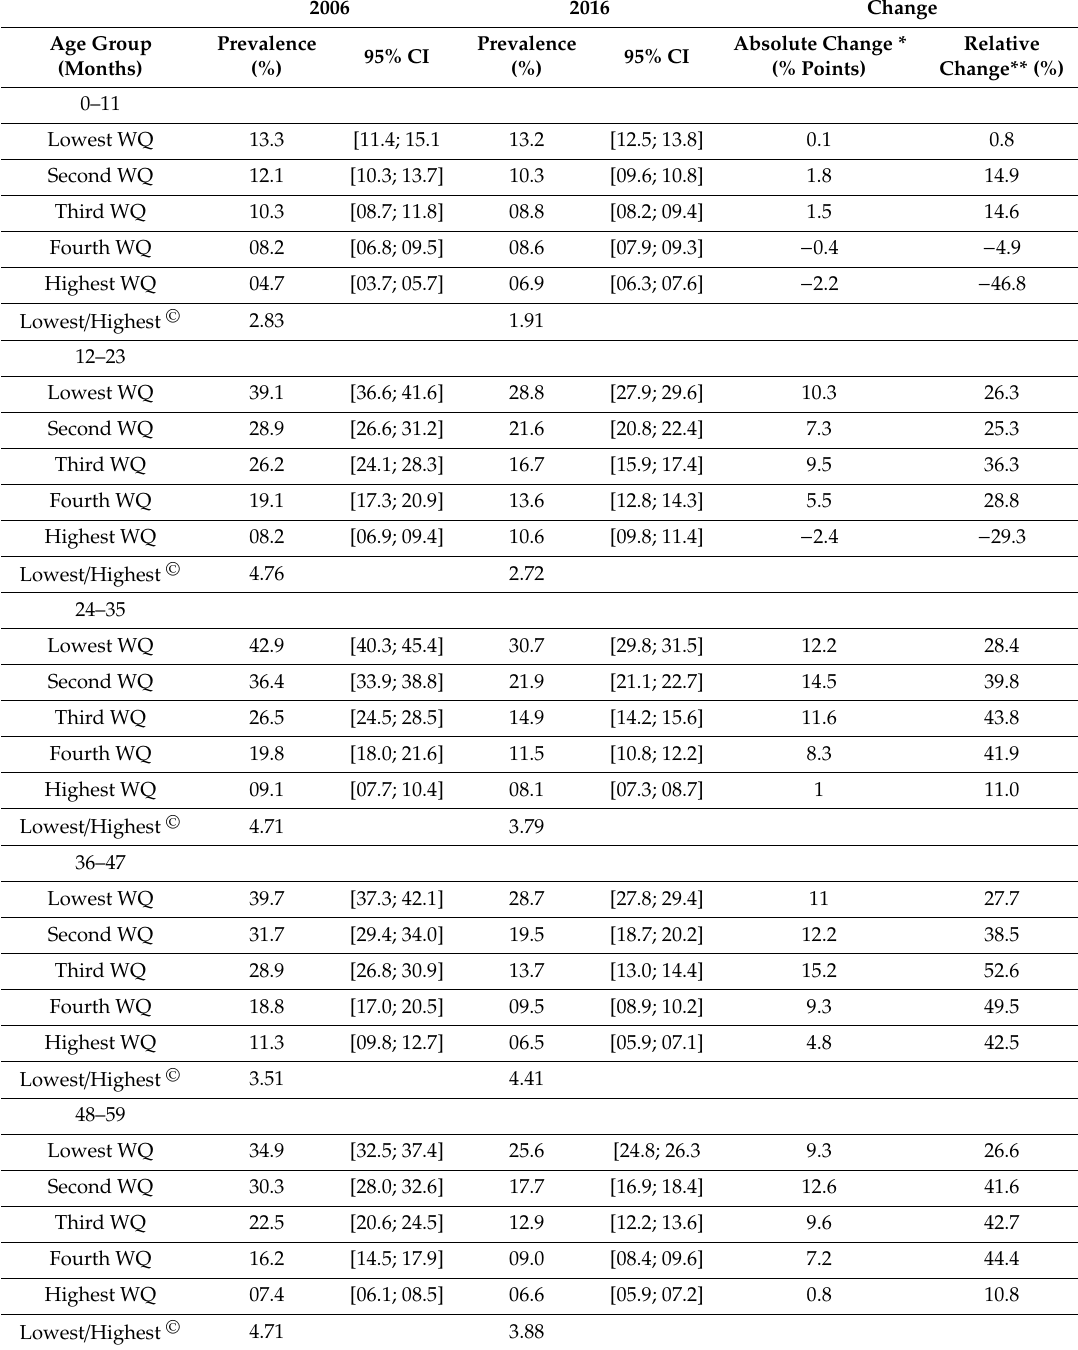
Table A3. Prevalence of severe stunting among children (below five years) by age groups and wealth quintiles, India, NFHS,